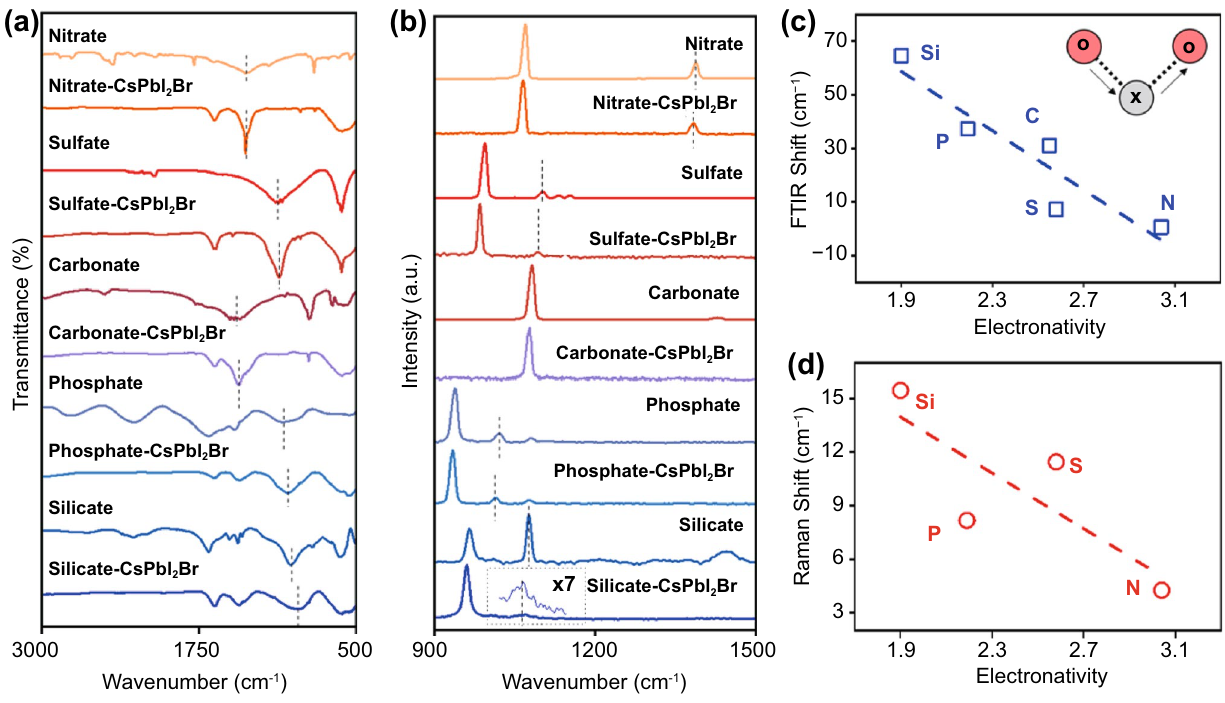
Fig. 2 a FTIR spectra and b Raman of oxysalts powders without and with perovskite components. The asymmetric stretch ( υ as ) peaks of oxy- salts are highlighted by dotted lines. Oxysalt and oxysalt-CsPbI 2 Br represent the pure oxysalt and the mixture of oxysalt and CsPbI 2 Br perovs- kite, respectively. The Raman asymmetric stretch peak of the mixture of silicate and CsPbI 2 Br is magnified 7 times. Shifts of c FTIR asymmetric stretch signals and d Raman asymmetric stretch bands of oxyacid anions by compositing with CsPbI 2 Br perovskites as a function of electronega- tivity. The inset image is the schematic of asymmetric stretching of O–X–O structure for oxyacid anions (X = N, S, C, P,